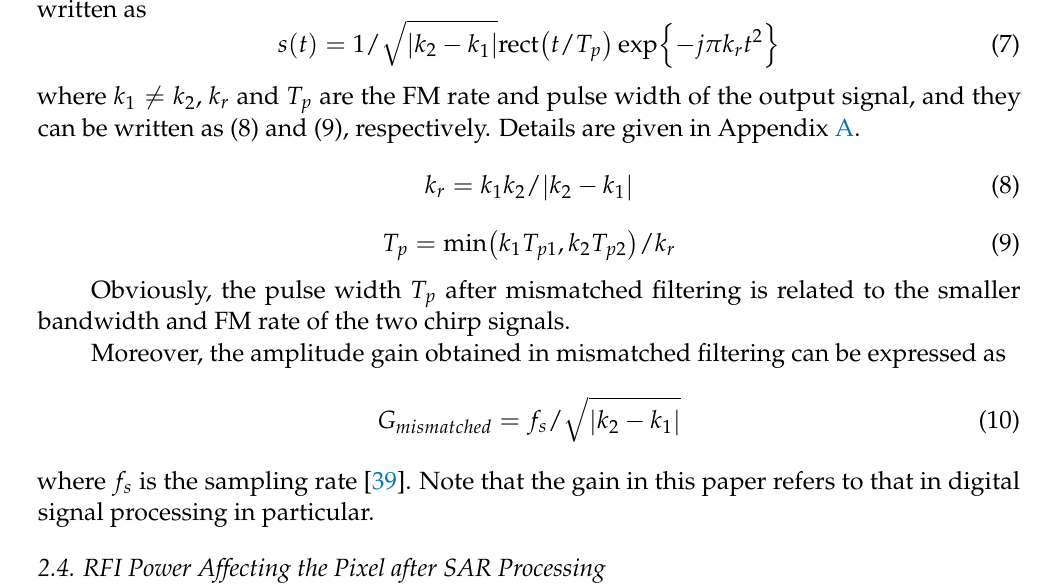
where LEO θ is the incidence angle of LEO SAR and p T is the time width after pulse com- pression in the range direction; according to (9), it can be written as